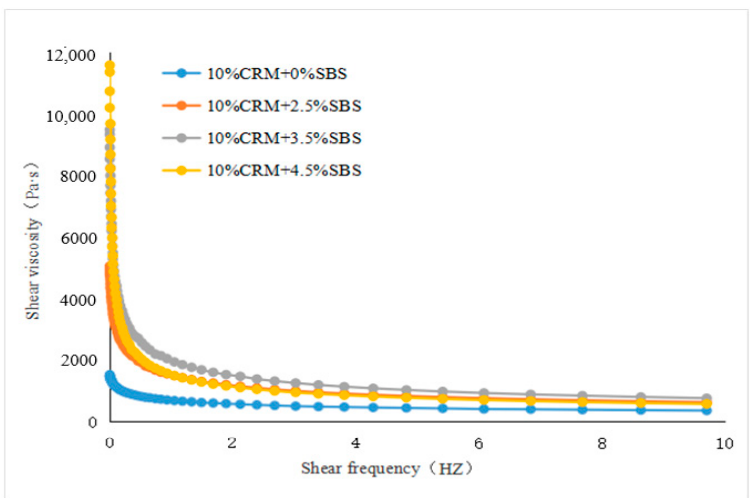
Figure 6. ZSV curves of Shell modified asphalt (fixed CRM and various SBS).